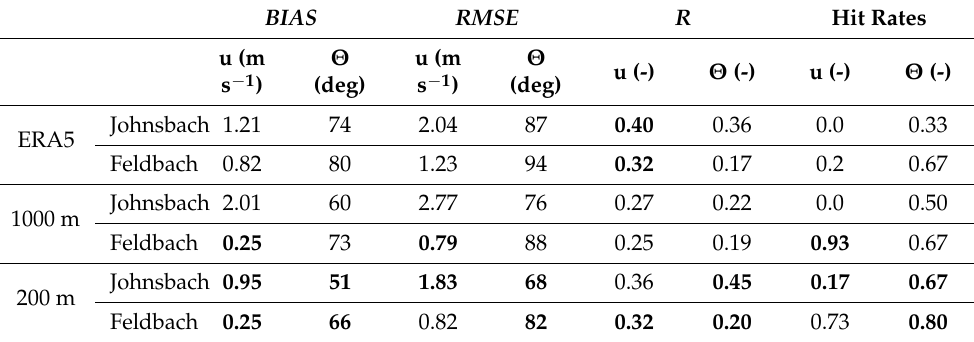
Table 3. Statistical performance indicators for wind speed and direction for the different model runs. Corresponding best-performance indicators are printed bold. BIAS RMSE R Hit Rates Θ u (m s − 1 )